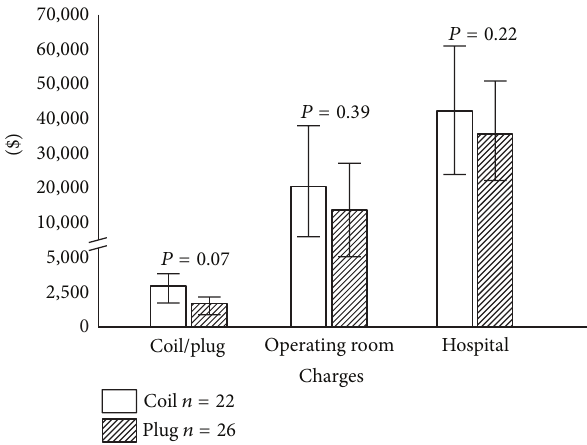
Figure 2: Economic analysis of internal iliac artery embolizations. Coil embolization (COIL) and Amplatzer Vascular Plug emboliza- tion (PLUG) charges, operating room charges, and total hospital charges for internal iliac artery embolizations performed prior to endovascular aneurysm repair for the time period from 2004 to 2010 (standardized to 2011 dollars). Reproduced with permission from